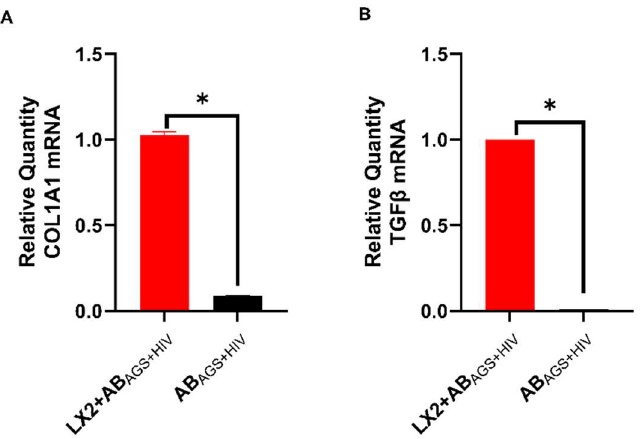
Figure A3. ABs derived from acetaldehyde and HIV-infected Jurkat cells did not activate HSCs : RT-PCR quantification of: ( A ) HIV gag RNA, ( B ) COL1A1 mRNA, ( C ) TGFβ1 mRNA, and ( D ) MMP2 mRNA. Data are from 3 independent experiments presented as mean ± SEM. Bars marked with the same letter are not significantly different; bars with different letters are significantly different from each other ( p ≤ 0.05).